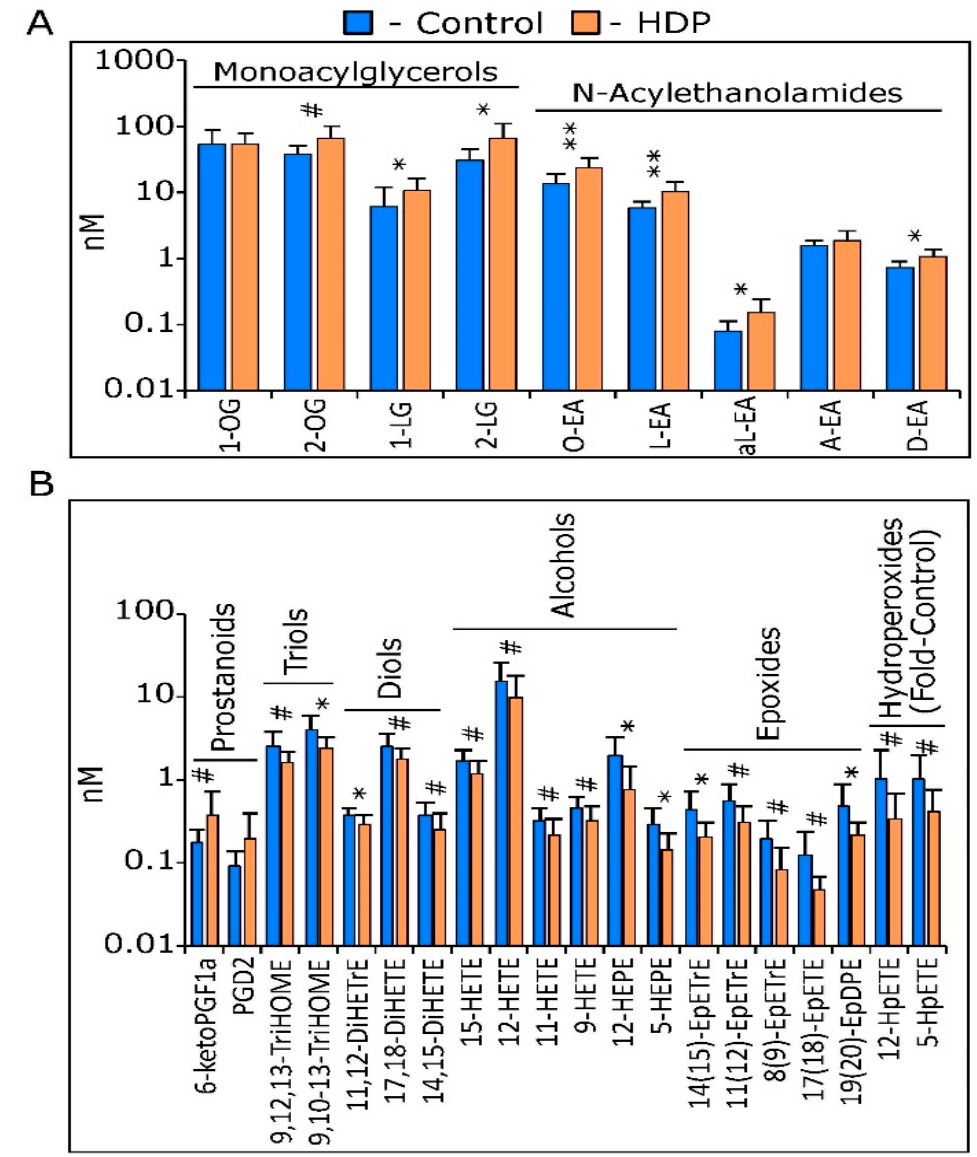
Figure 2. Selected plasma lipids in controls ( n = 10) and hemodialysis patients (HDP; n = 9), measured by UPLC-tandem mass spectrometry. With the exception of 1-OG and AEA, all metabolites showed group discrimination power in a partial least squares-discriminate analysis with variable importance in projection scores > 1 (Figure 1). ( A ) Endocannabinoid and endocannabinoid-like compounds, including monoacylglycerols and N-acylethanolamides. ( B ) Oxylipins, including prostanoids, triols, diols, alcohols, epoxides, and hydroperoxides. Hydroperoxide levels were estimated from internal standard corrected-area responses and are expressed as fold-control. Results are expressed as the mean ± SD. The p -values < 0.05 are rounded to 1 significant figure. Group mean differences were assessed on log-transformed data by 2-tailed t- tests, with annotations indicating p -values (** ≤ 0.01; * ≤ 0.050, # ≤ 0. 10). Table 2. Plasma endocannabinoid and oxylipin subset levels in healthy controls and hemodialysis patients a,b . Parent Compound Units Fatty Acid